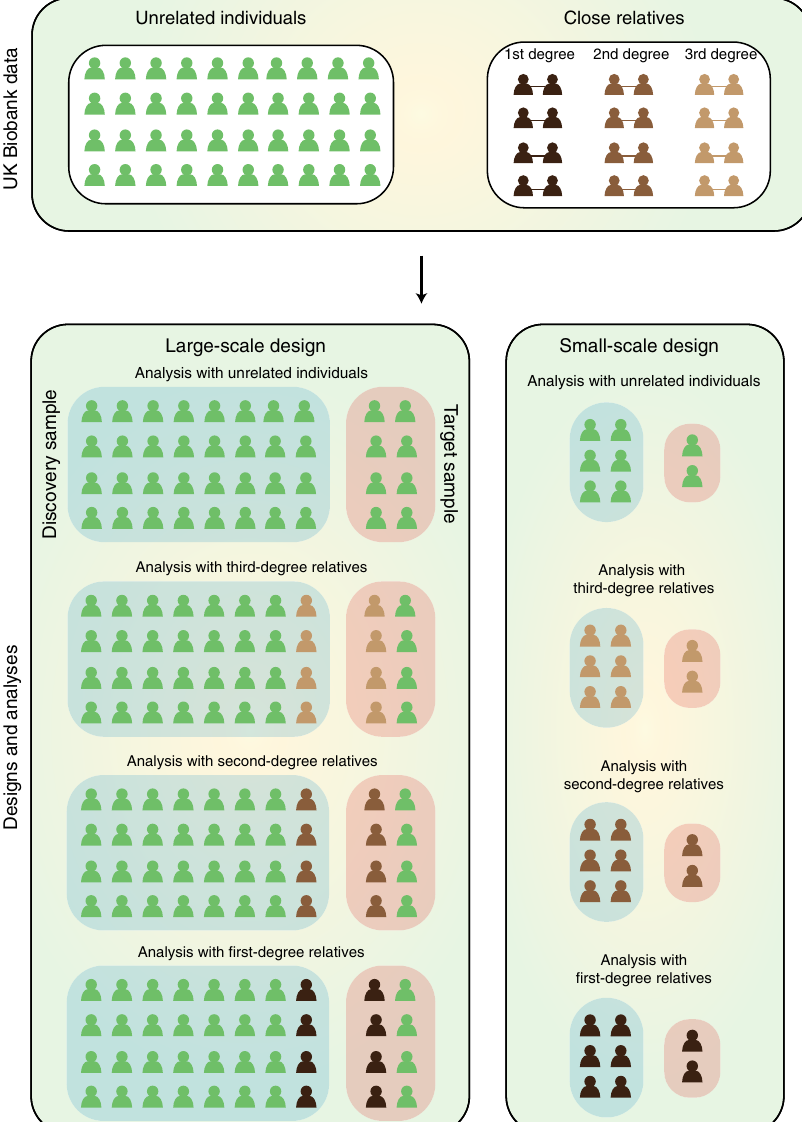
Fig. 1 A schematic illustration for study designs and analyses. We made large- and small-scale designs, each having four analyses with unrelated, fi rst-, second- and third-degree relationships between discovery and target samples. Initially, we identi fi ed 288,837 unrelated individuals for whom any pairwise relationship was less than 0.05 (green). We also identi fi ed fi rst- (dark brown), second- (brown) and third-degree (light brown) relatives using the information of kinship coef fi cients from the full UK Biobank sample. The analysis with the unrelated sample in the large-scale design was carried out for all unrelated individuals with available phenotypic information who were randomly divided into discovery (80%) and target data sets (20%). For the analysis with fi rst-, second- or third-degree relatives in the large-scale design, the set of fi rst-, second- or third-degree relatives were substituted with a set of the same number of randomly selected individuals in the analysis with unrelated sample. For the analysis with unrelated sample in the small-scale design, we used 6000 individuals (5000 as discovery, and 1000 as target sample), randomly selected from the analysis with unrelated sample in the large-scale design. However, with the analysis with fi rst-, second- or third-degree relatives in the small-scale design, we selected 6000 individuals from the set of fi rst-, second- or third-degree relatives, maximising the relationships among the selected individuals (see ‘ Methods ’ scale design (Supplementary Table 3), as expected. As in the large-scale design, there were four different analyses in the small- scale design of 6000 individuals with (1) the unrelated individuals only, (2) the fi rst-degree relationship pairs, (3) the second-degree relationship pairs and (4) the third-degree relationship pairs (see Fig. 1 and Supplementary Table 3). In the target data set, prediction accuracy was empirically calculated as the correlation between the polygenic scores based on SNP effects estimated in the discovery data set 35 and the phenotypes adjusted for potential confounders (see ‘ Methods ’ ).